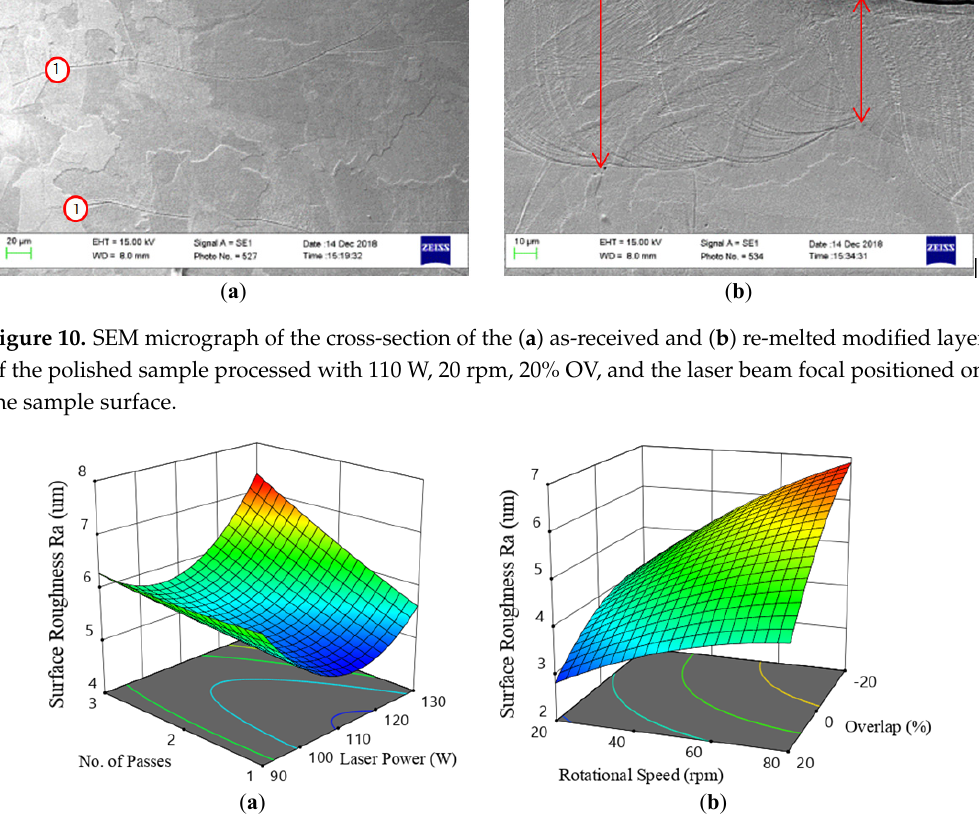
Figure 10. SEM micrograph of the cross-section of the ( a ) as-received and ( b ) re-melted modified